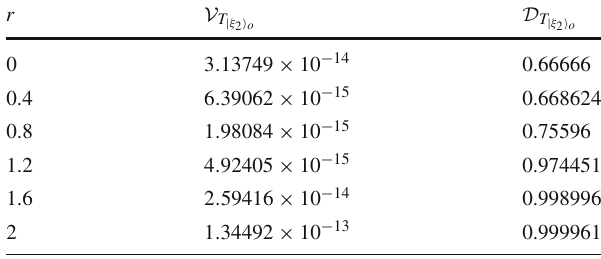
Table 4 Numerical values of density fluctuations and dimensionless parameter in TMSV states for squeezing parameter